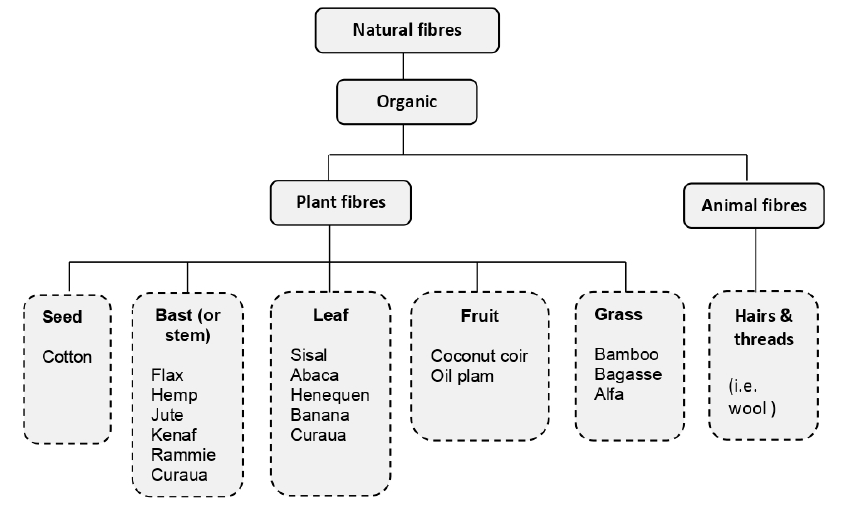
Figure 1. Classification of natural fibers commonly used in cement and geopolymer composite production production [20,21].